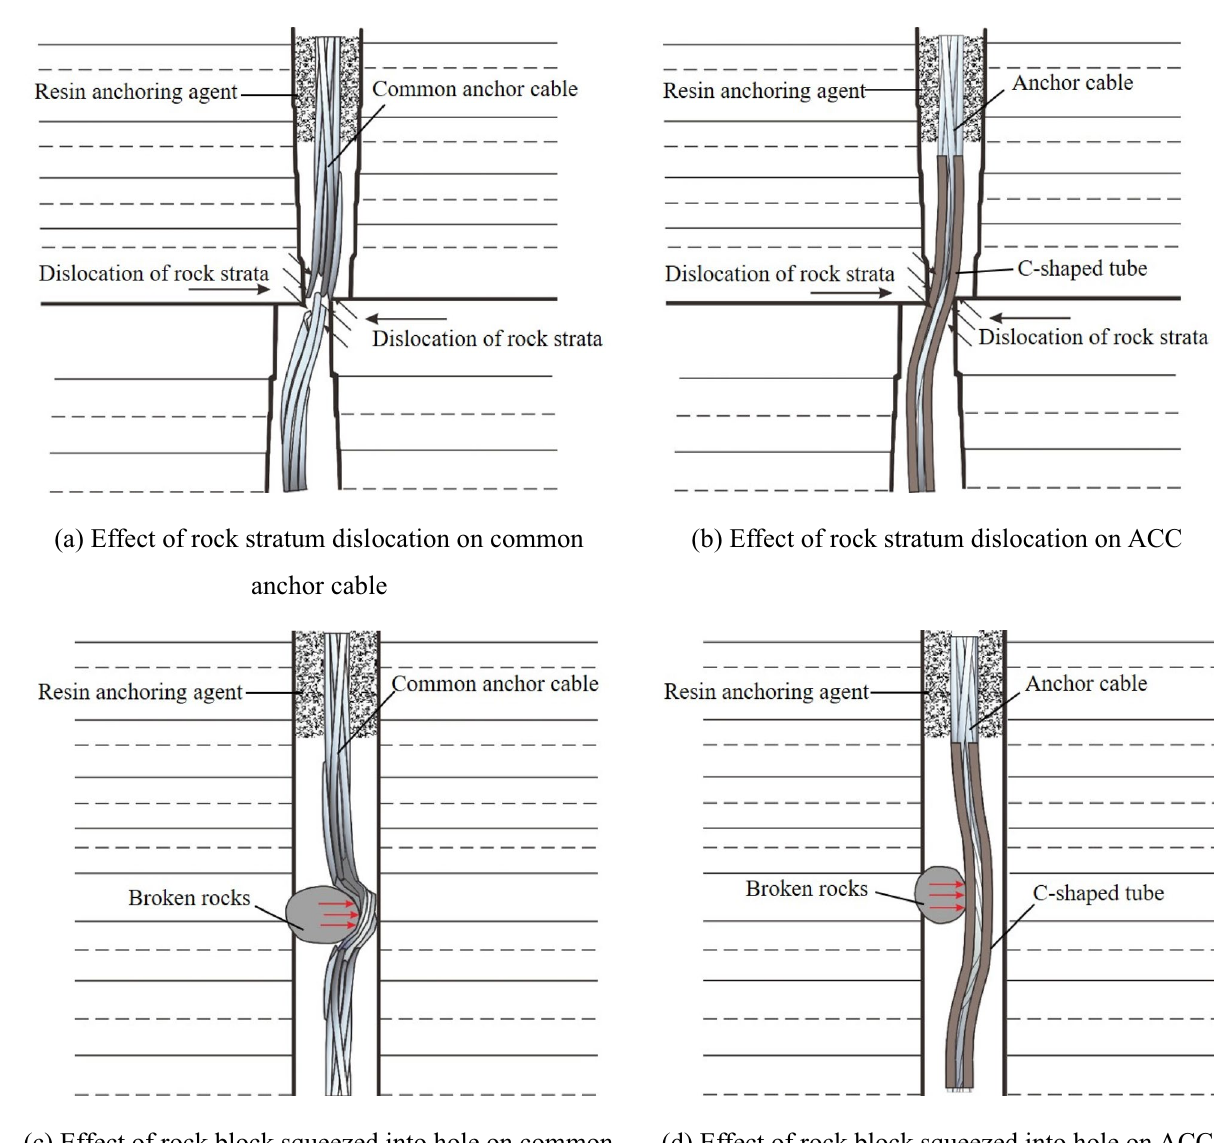
Figure 2. Schematic diagram of action mechanism of common anchor cable support and ACC support.